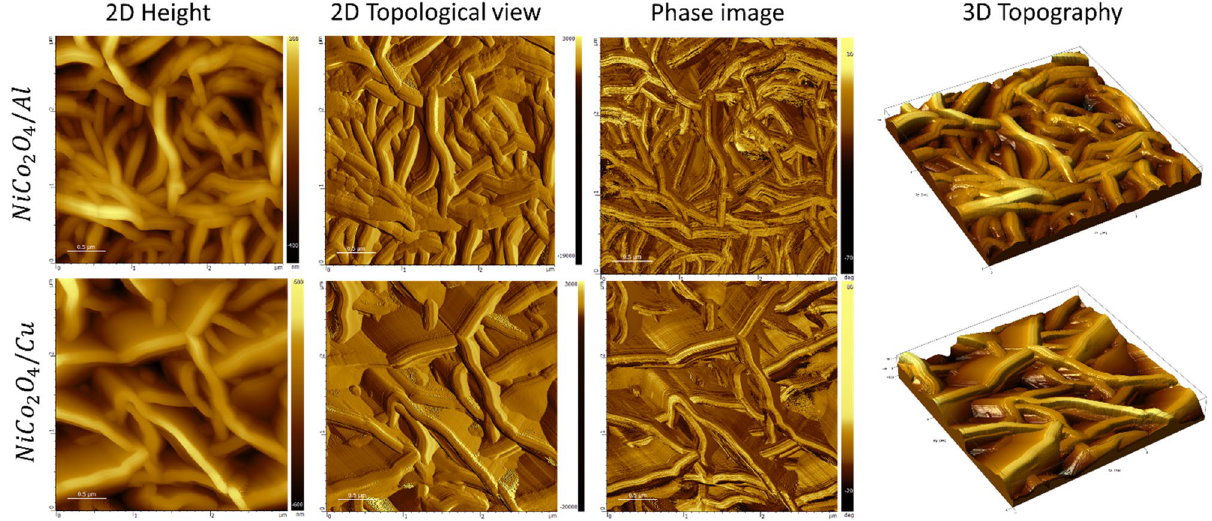
Fig. 4 AFM images in 2D, topological view, phase image, and 3D image for NiCo